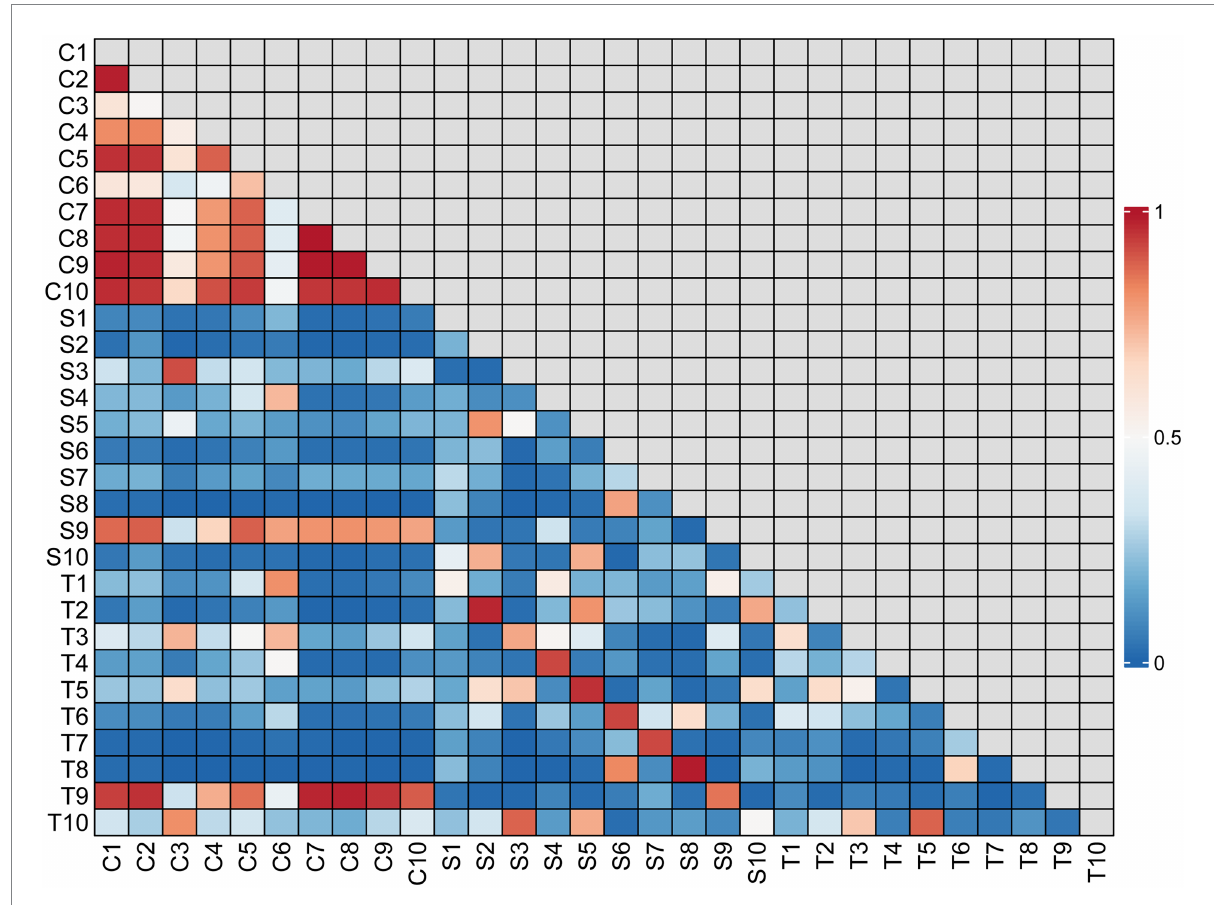
FIGURE 4 Correlation matrix for all samples. The correlation coefficient values are indicated by different shades of color according to the scale to the right of the matrix. The scale ranges from 0 to 1, where 1 represents the most similar